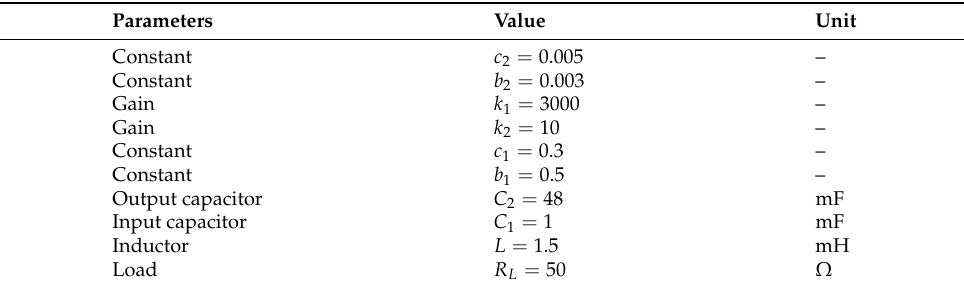
Table 3. MATLAB simulation parameters.